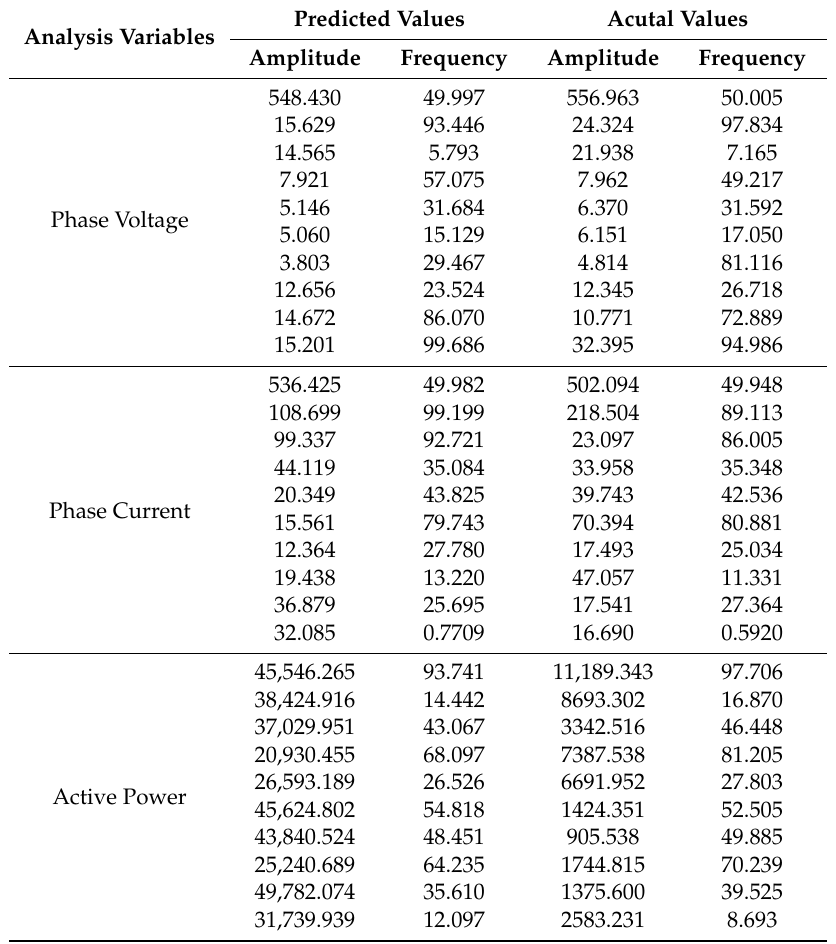
Table 5. The analysis results of the actual value and forecast value based on Prony